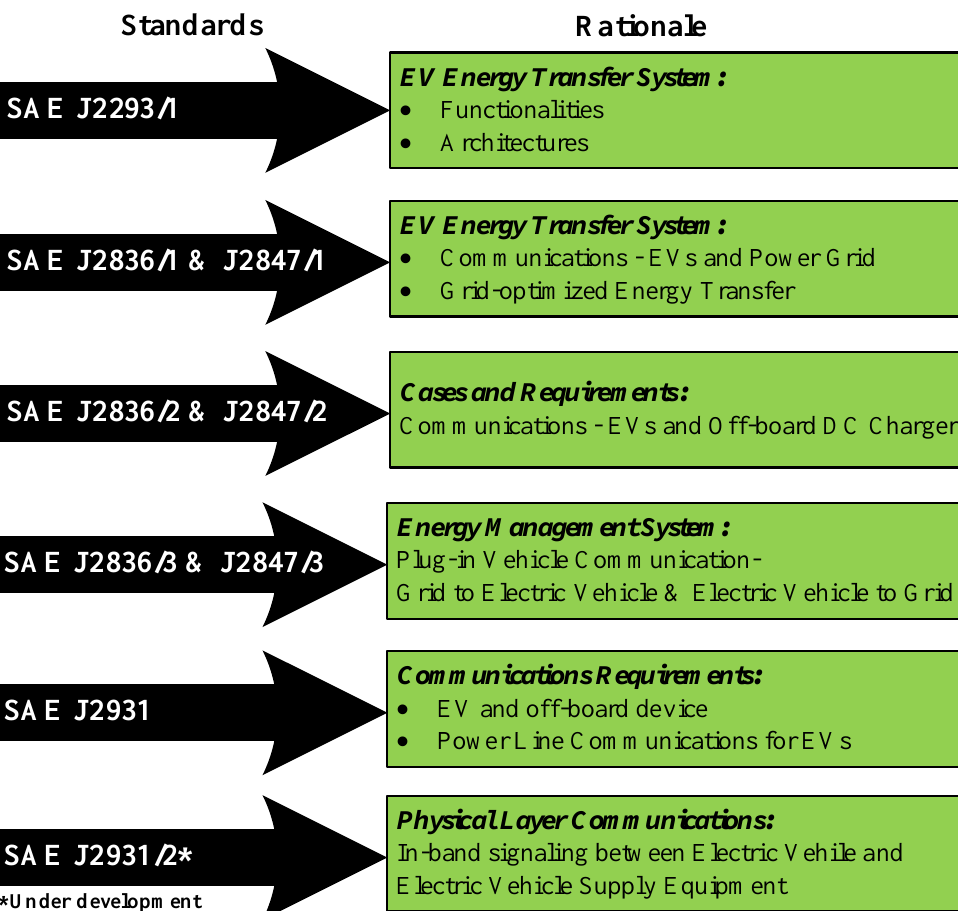
Figure 1. SAE Communication Standards for EV Charging [11–18]. In addition, the International Electrotechnical Commission (IEC) is industrialized numerous guidelines for the DC rapid charging alternative under development. IEC 61851-23 sets out specifications for gird links and Fast Charging (FC) contact systems. IEC 61851-24 forms the concept of digital contact between EVs and charging stations. The SAE Subcommittee on vehicle control and communications has recognized a procedure for the proposal and usage of devices that communicate electronic indications and control data between EV components. The communication requirements between an EV and a charging facility at different locations are shown in Figure